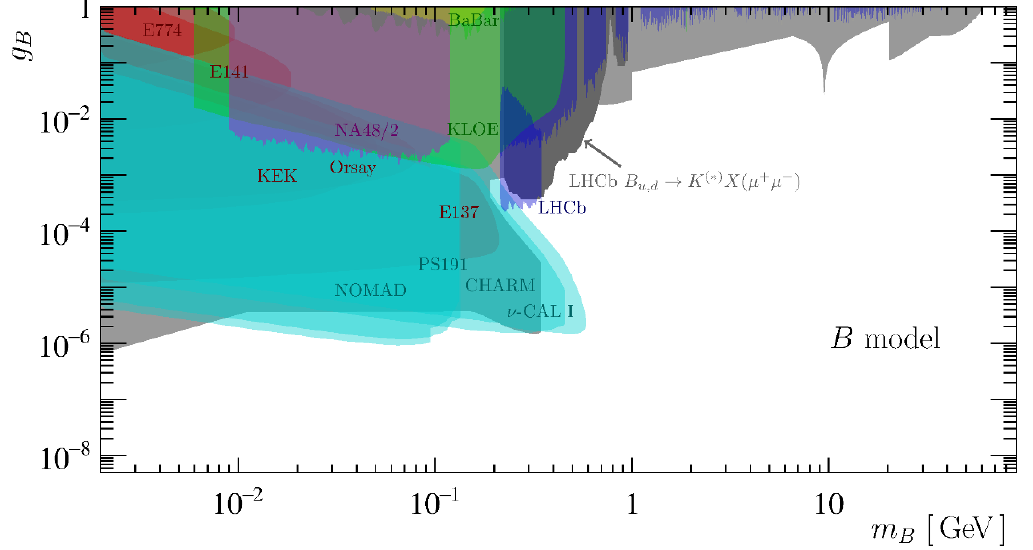
Figure 6 . Constraints derived on visible B decays using the same experimental color scheme as in (cid:12)gure 4. The grey constraints come from (cid:7) [102, 103] and (cid:17) [76, 104] decays, from longitudinal- mode enhancements [73, 74] in B u;d KX [105], K (cid:25)X [106, 107], and Z X(cid:13) [108, 109] ! ! ! processes, and from the lack of observed new anomaly-canceling fermions [73, 74, 95]. The dark grey constraints, which are obtained in this work following refs. [73, 74], are from the LHCb searches for B u;d K ( (cid:3) ) X with X (cid:22) + (cid:22) (cid:0) [93, 94]. ! !